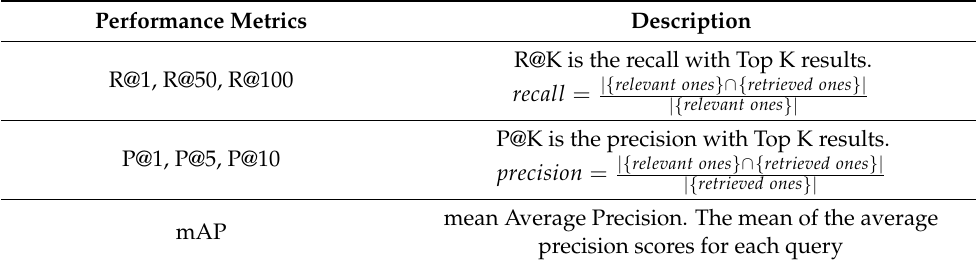
Table 2. Performance